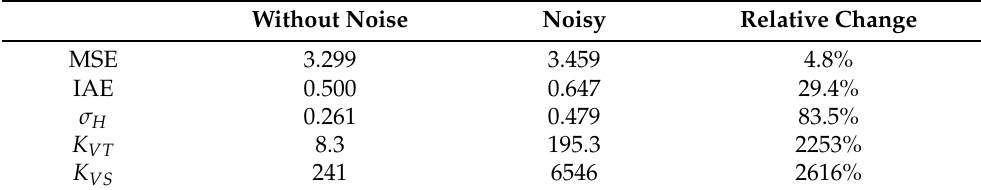
Table 2. G 1 ( s ) CPA indexes.